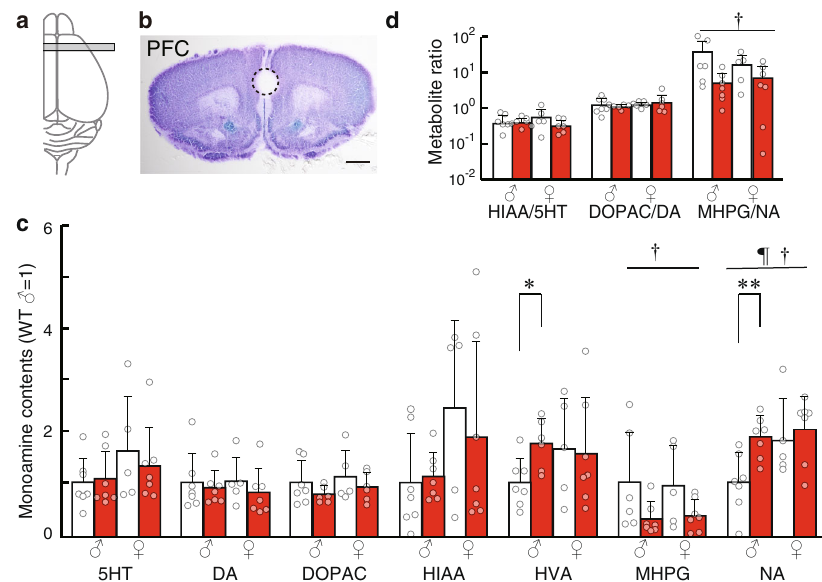
Fig. 4 Monoamine levels measured through high-performance liquid chromatography. a Coronal brain sections were prepared from the illustrated areas. b Cresyl violet staining of the sections used for sampling. Positions of the punch biopsy are indicated by circle. c Monoamine contents in P7 WT and KO mice. The mean value of male WT mice was de fi ned as 1. Absolute values are indicated in Supplementary Fig. 5. 5HT serotonin; DA dopamine, DOPAC 3,4- dihydroxyphenylacetic acid, HIAA 5-hydroxyindole acetic acid, HVA 3-methoxy-4- hydroxyphenyl acetic acid, MHPG 3-methoxy-4-hydroxyphenylglycol, NA noradrenaline. d Monoamine turnover ratios. The ratios mean (metabolite content)/(monoamine content). n = 5 – 7 mice per genotype. Outliers were removed after Grubbs ’ s test. Data were presented as mean ± SD. * P < 0.05; ** P < 0.01 in t -test. † P < 0.05; †† P < 0.01; ††† P < 0.001 in two-way ANOVA (genotype and sex as main factors, genotype effect). ¶ P < 0.05 in two-way ANOVA (genotype and sex as main factors, sex effect). Scale bar , 100 µ